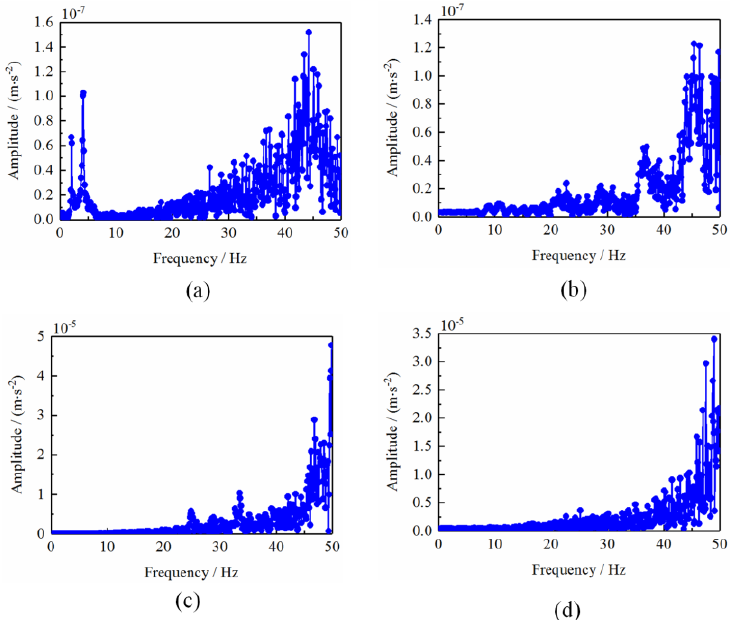
Figure 7. Frequency spectrum characteristics of the vibration signal. ( a ) Single water phase, ( b ) Oil–water two-phase, ( c ) Gas–oil–water mixing phase, ( d ) Single gas phase.